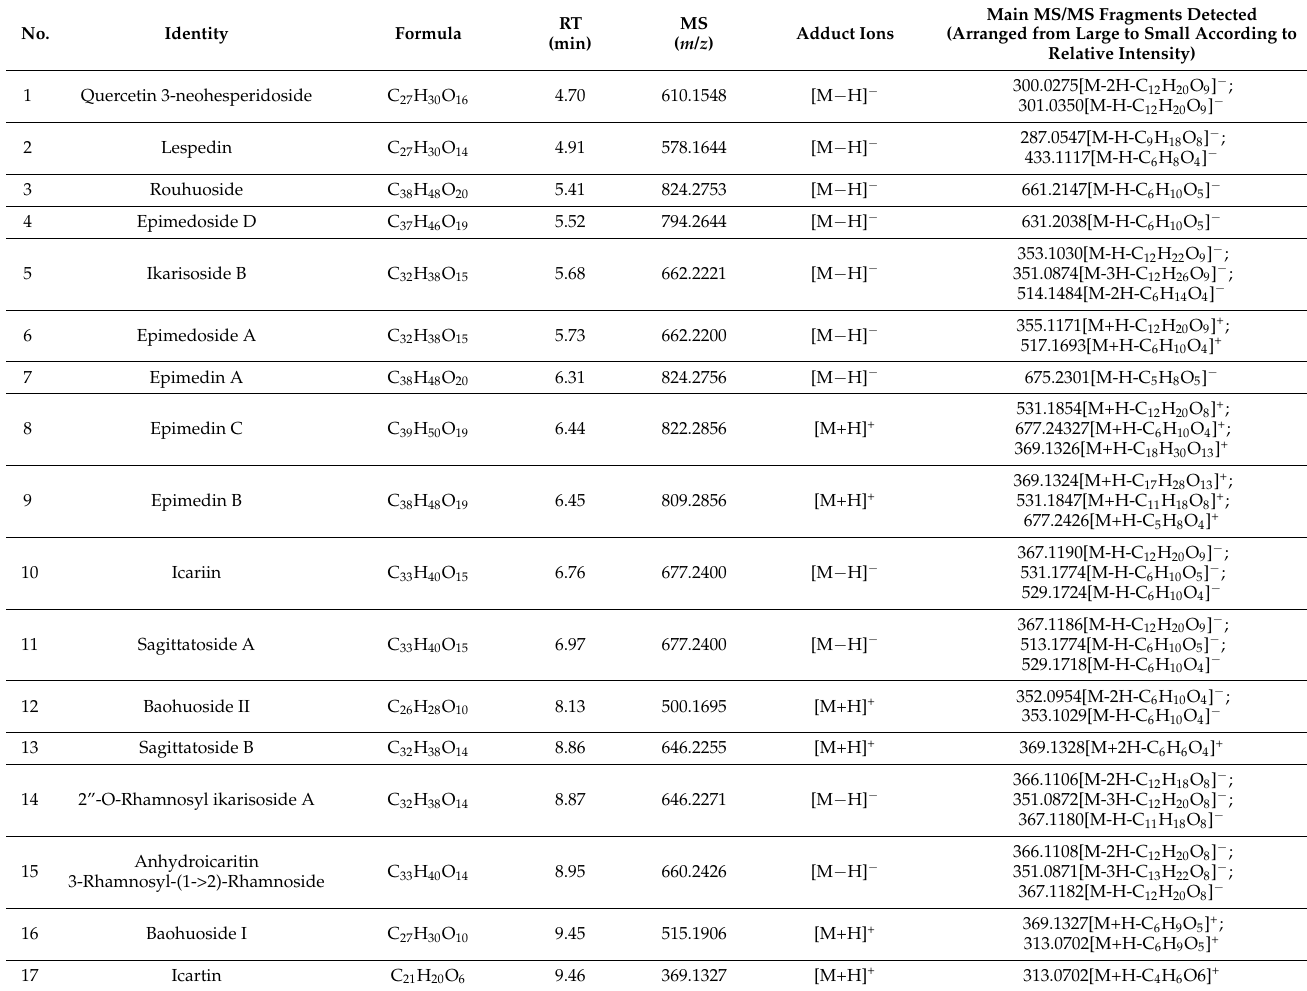
Table 1. Flavonoid compounds tentatively identified in EM extract, from UHPLC-Q-TOF/MS.